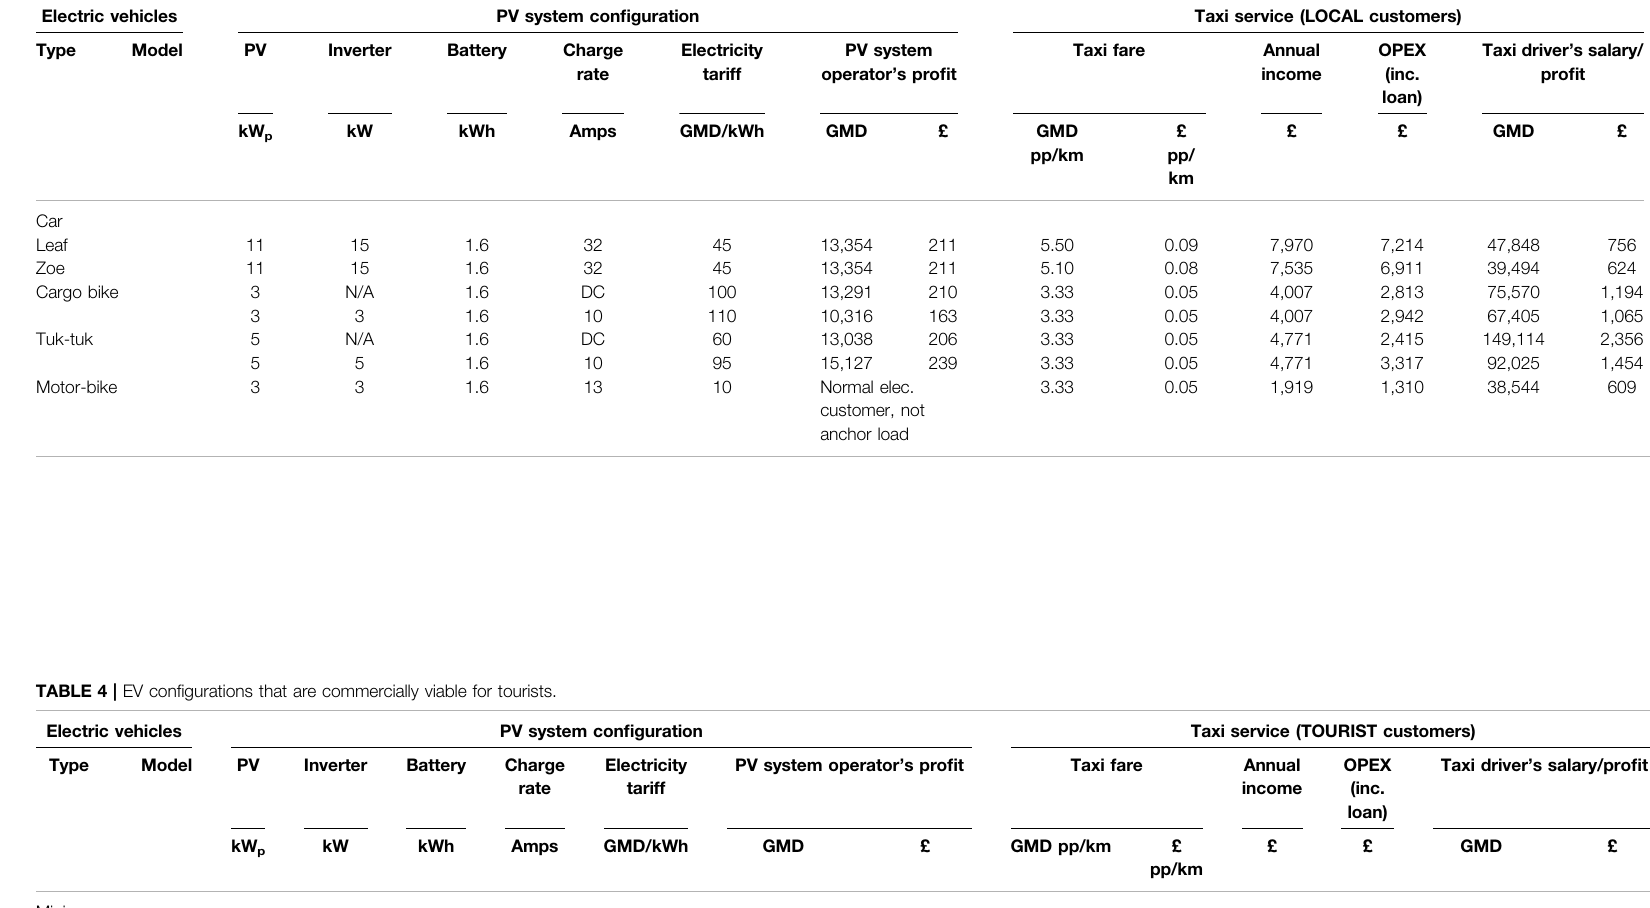
TABLE 3 | EV con fi gurations that are commercially viable for local customers.